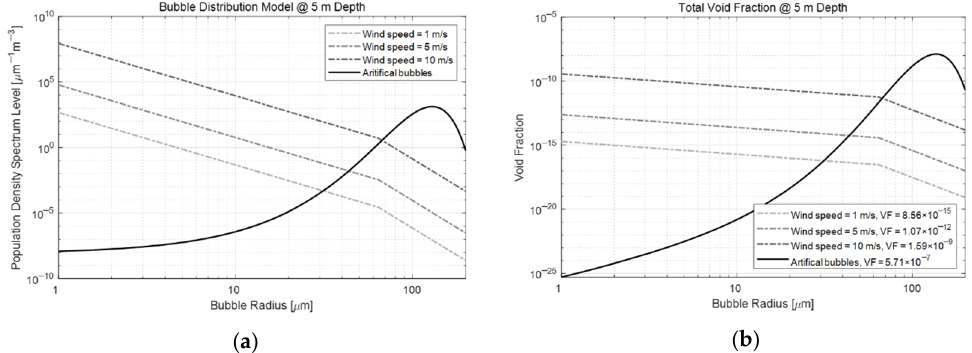
Figure 8. Estimated ( a ) PDSL and ( b ) VF of the artificial bubbles (solid lines) and natural bubbles (dashed lines).